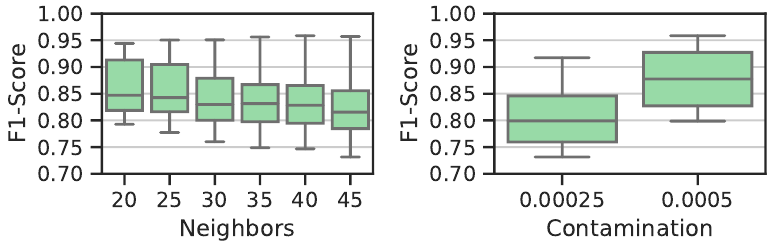
Figure 4. F1-Score obtained with LOF across several Number of Neighbors and Contamination